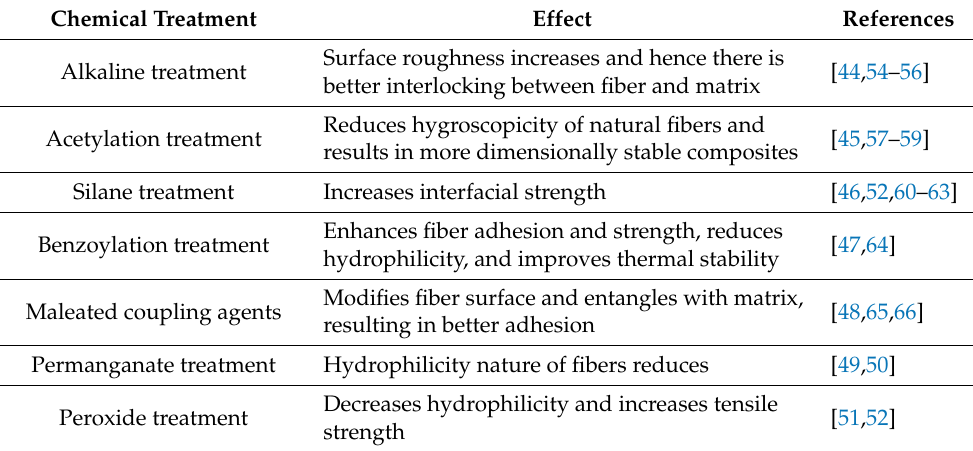
Table 2. Various chemical treatments and their effects.